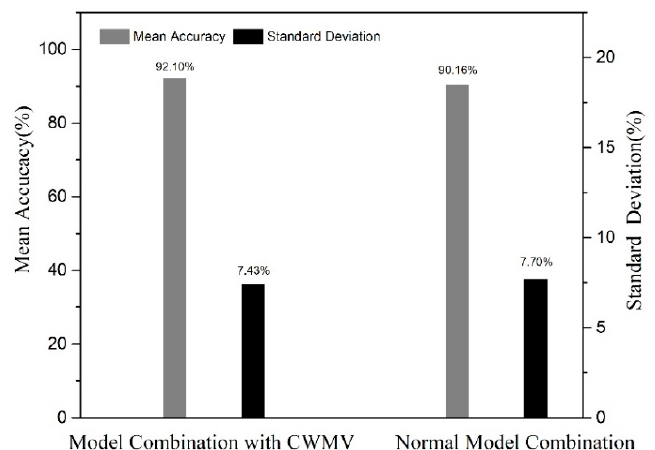
Figure 10. Performance comparison between the class-specific weighted majority voting and the traditional weighted majority voting.